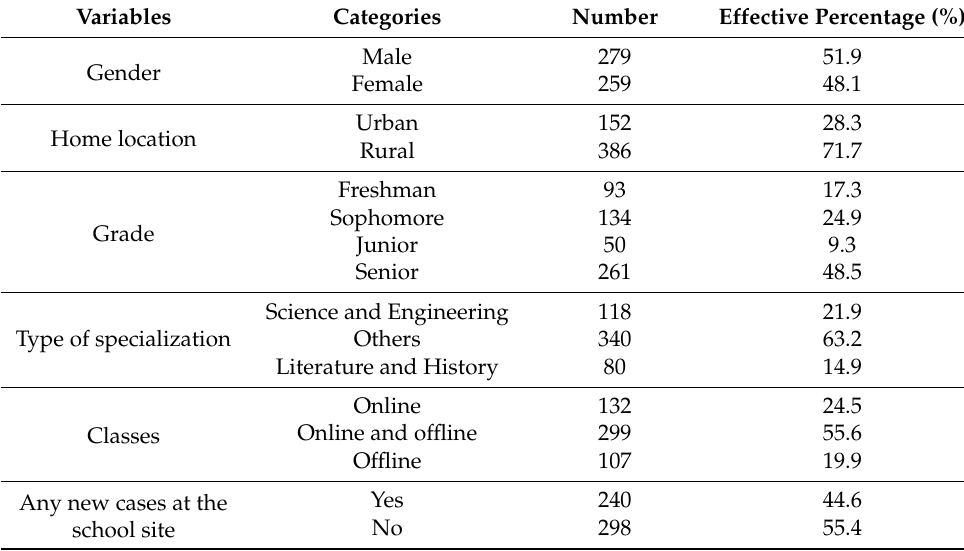
Table 1. Results of statistical analysis of subjects ( n =